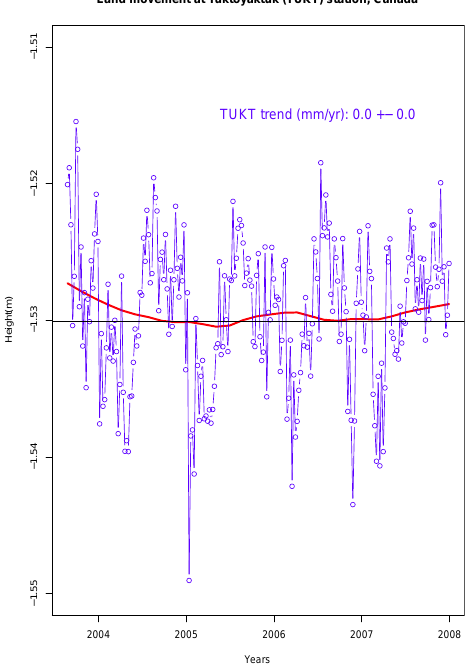
Fig.15. TheCanadianstationTuktoyaktukshowsazerolandmovementtrendoverthelast4.3yearsofthecampaign. Fig. 16. The Canadian GPS station Tuktoyaktuk has close to zero height trend over the years